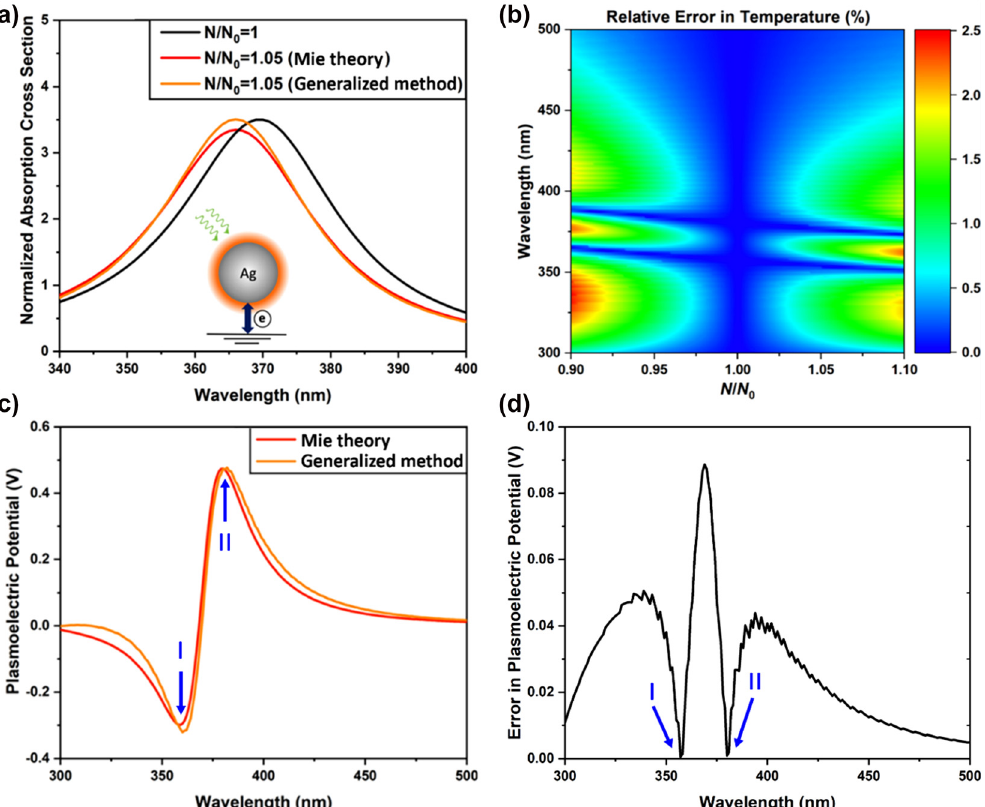
Figure 1: Validity test of generalized method in comparison with strict theoretical analysis. (a) Comparison between normalized absorption cross sections for a silver nanosphere of 10 nm in radius without and with charge transfer betweenthesphereandtheground( N / N 0 >1).(b)Relativeerrorintemperaturesderivedfromourgeneralizedcalculationmethodandtherigorous theoretical treatment. (c) Comparison between the PEP spectra calculated by the generalized calculation method and the rigorous theoretical treatment. (d) Error (absolute difference) in PEP obtained our generalized method compared to the rigorous theoretical treatment. “ I ” and “ II ” marked in (c) and (d) demonstrate the high accuracy of our method in predicting PEP at the wavelengths of interest for practical